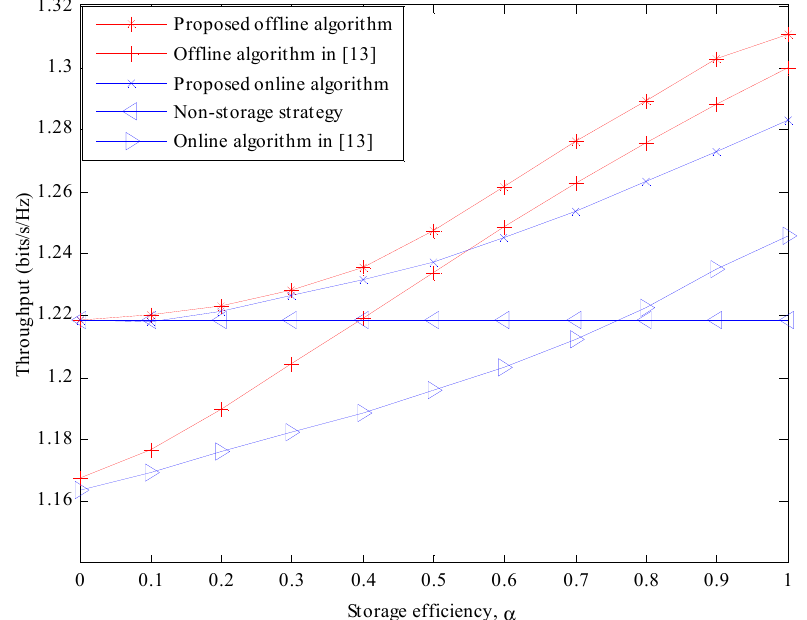
Figure 5. Throughput for the time-varying channel with energy arrivals obeying the uniform distribution of [5, 20] mJ.